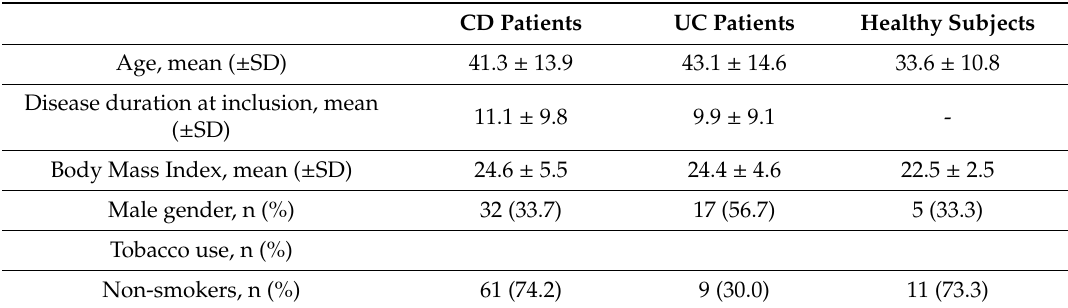
Table 1. Characteristics of Crohn’s disease patients, ulcerative colitis patients and healthy subjects included in the